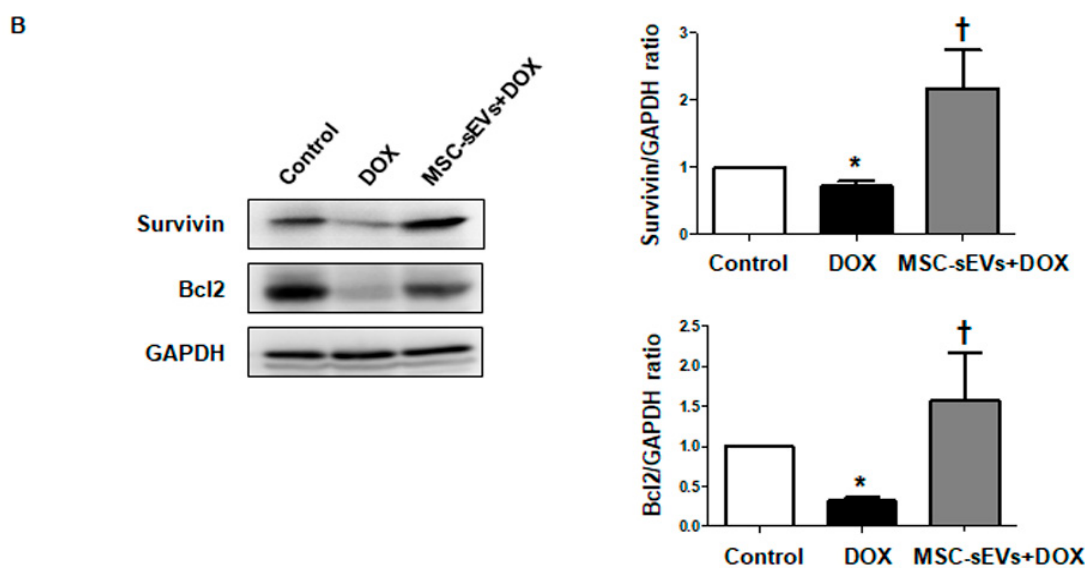
Figure 9. MSC-sEVs attenuate cardiomyocyte apoptosis by upregulation of anti − apoptotic proteins (survivin and Bcl2) in an in vivo mouse model. ( A ) Immunofluorescence staining to detect Bcl − 2 and survivin in various regions of the mouse myocardium. The heart tissues were stained with anti − Bcl − 2 antibody (yellow) and anti − survivin antibody (red), while nuclei were stained with DAPI (blue). The expression levels of Bcl − 2 and survivin were compared among the three groups (control, DOX and MSC-sEVs + DOX) using confocal microscopy. Representative images are shown (magnification 400 × ; scale bars, 20 μ m). ( B ) The protein levels of survivin, Bcl − 2, and GAPDH in the heart tissue of mice were measured by Western blotting ( n = 8/group). Representative images are shown. * Significant difference compared to the control ( p < 0.05). † Significant difference compared to DOX treatment ( p < 0.05).